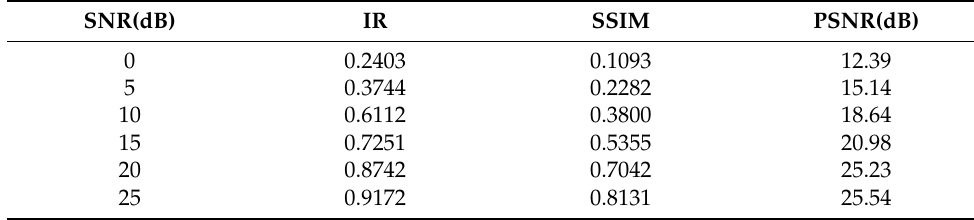
Table 3. The metrics of proposed method at different SNRs.